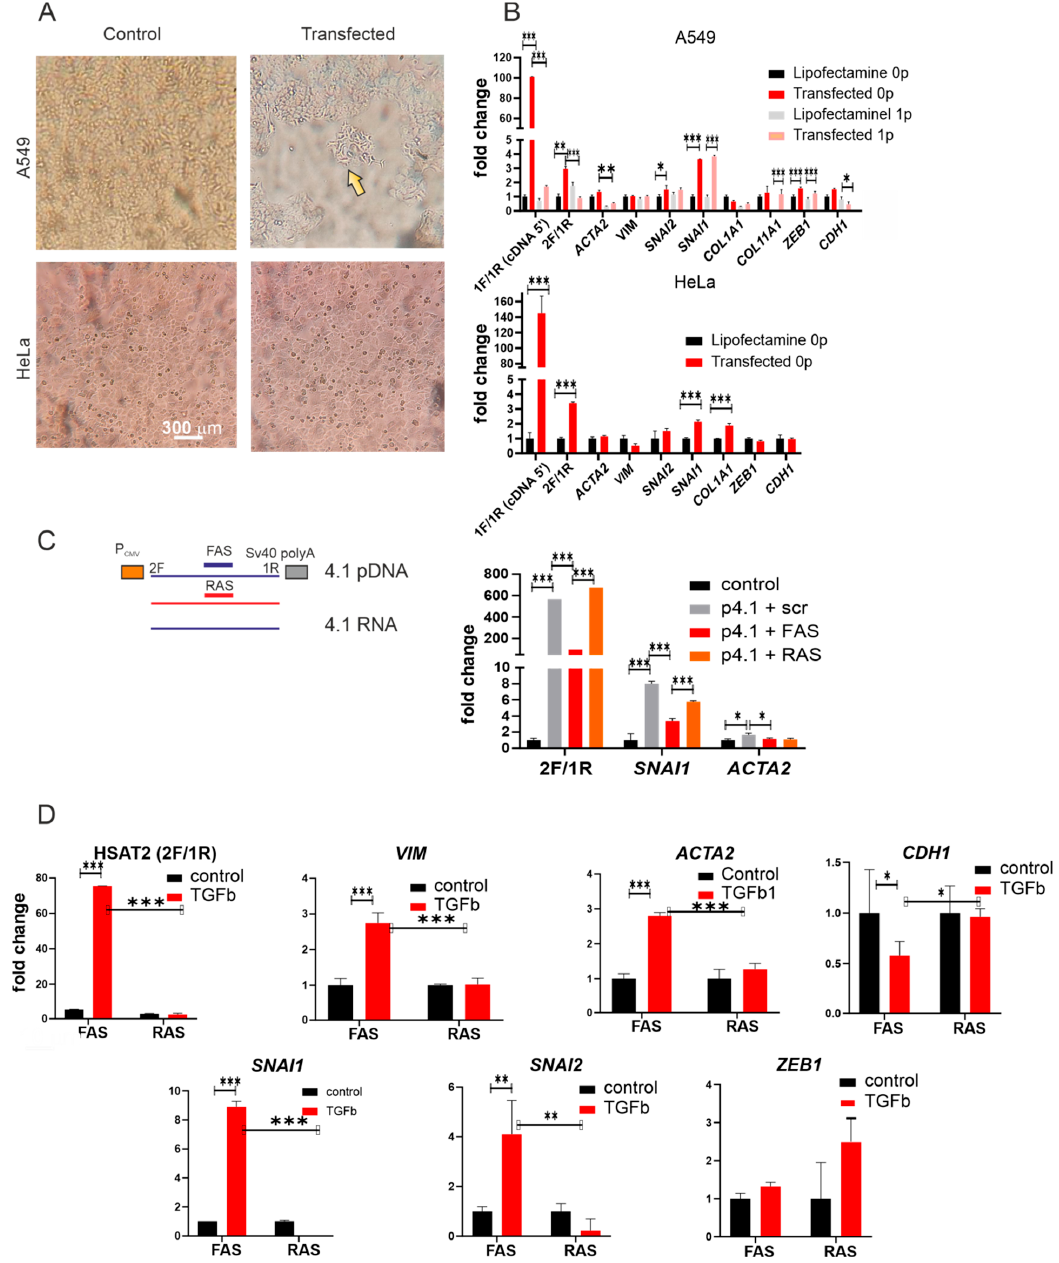
Figure 4. HSAT2 transcription influence on EMT. ( A ) Morphology of A549 and HeLA cell cultures transfected with 4.1 plasmid. Arrow—cells with non-epithelial morphology. ( B ) Quantification of EMT marker gene transcription in transfected A549 and HeLa cells. 0 p—transfected cells be- fore the first splitting; 1p—after the first splitting. ( C ) Knockdown of 4.1 (Acc No OP912406.2) transcripts in transfected A549 cells. The left image shows a scheme of FAS and RAS 2-o-Me/LNA- modified oligonucleotides annealing on 4.1 sequence strands, CMV—cytomegalovirus promoter in the plasmid; 2F, 1R—the primer position (see Table 2 for primer sequences and abbreviations). Right image—quantification of 4.1 transcript in cells co-transfected with the overexpression plasmid (p4.1) and either scramble (scr), FAR, or RAS—2-o-Me/LNA-modified oligonucleotides; control—cells treated with lipofectamine only (without DNA). ( D ) Influence of FAS and RAS antisense oligonu- cleotides on EMT markers’ mRNA level in A549 cells treated with TGF β 1 to induce EMT. The abbreviations are the same as in C. See Table 2 for the primer sequences and targets. *— p < 0.05, **— p < 0.01, and ***— p <